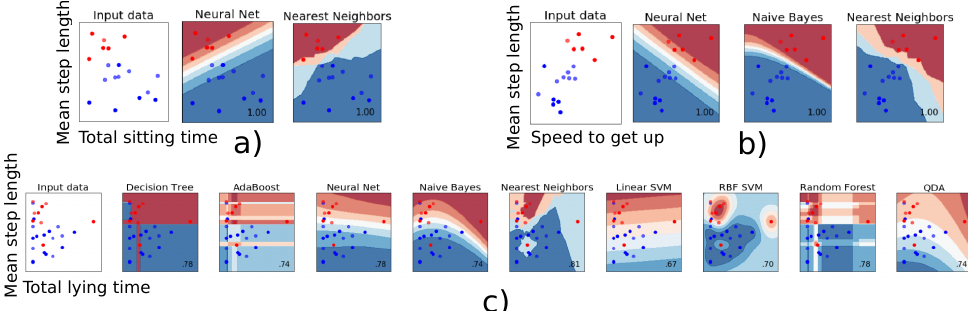
Figure 2. The classifier decision function between the patients who have a low (red) or a high risk of fall (blue) is represented for the combination of two parameters. ( a , b ): Individuals are clearly ‘split’ into two distinct categories. ( c ): These two parameters do not allow clearly classifying the